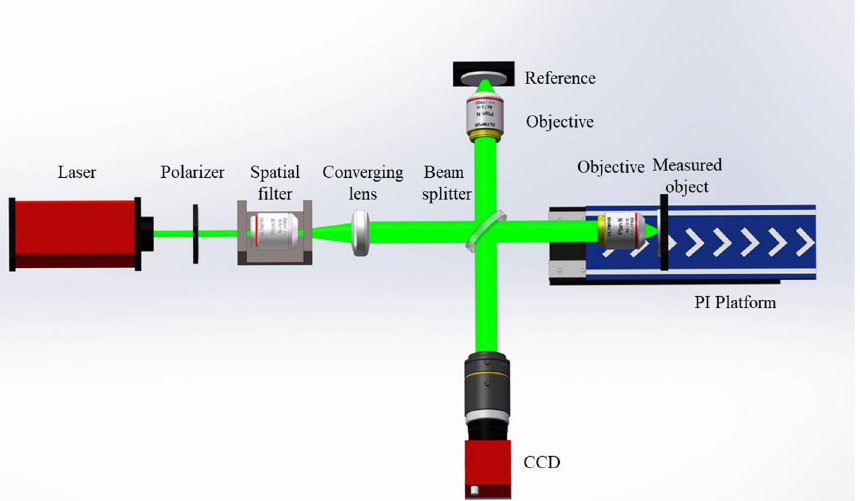
Figure 5. The optical path structure diagram.